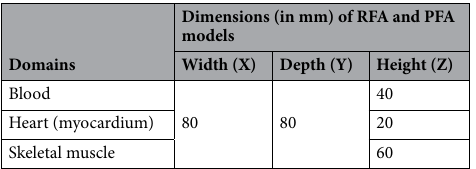
Table 3. Geometrical dimensions of the slabs for RFA and PFA